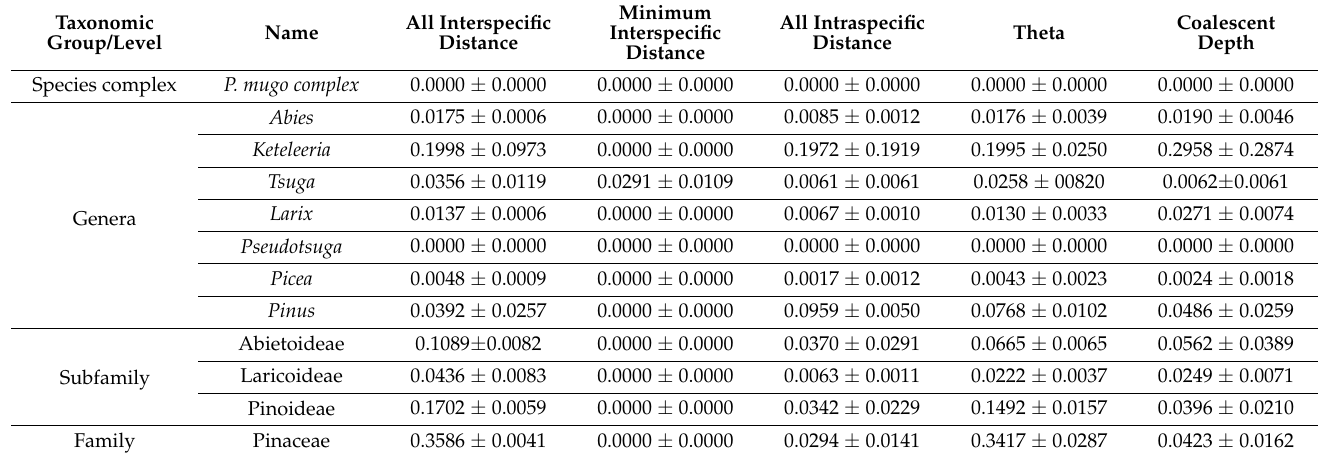
Table 2. Values of genetic divergence indices in ITS2 sequences in